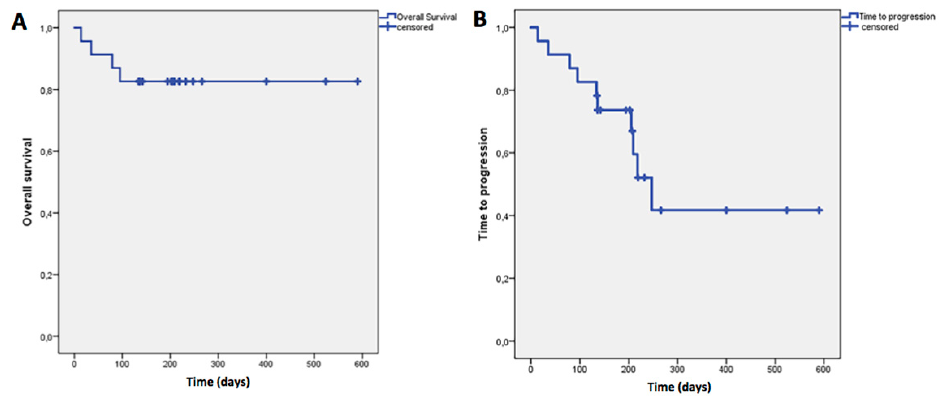
Figure 5. ( A ) Overall Survival (OS), defined as the time from the start of treatment until the date of death; ( B ) Time to Progression (TTP), assessed as the time from the start of treatment until progression of disease or death. The mean OS was 497 days (95% CI: 414–580 ± 42.3) while the mean TTP was 339 days (95% CI: 229–449 ± 56). Both OS and TTP were influenced by the number of chemotherapy cycles (Log Rank = 35.406,